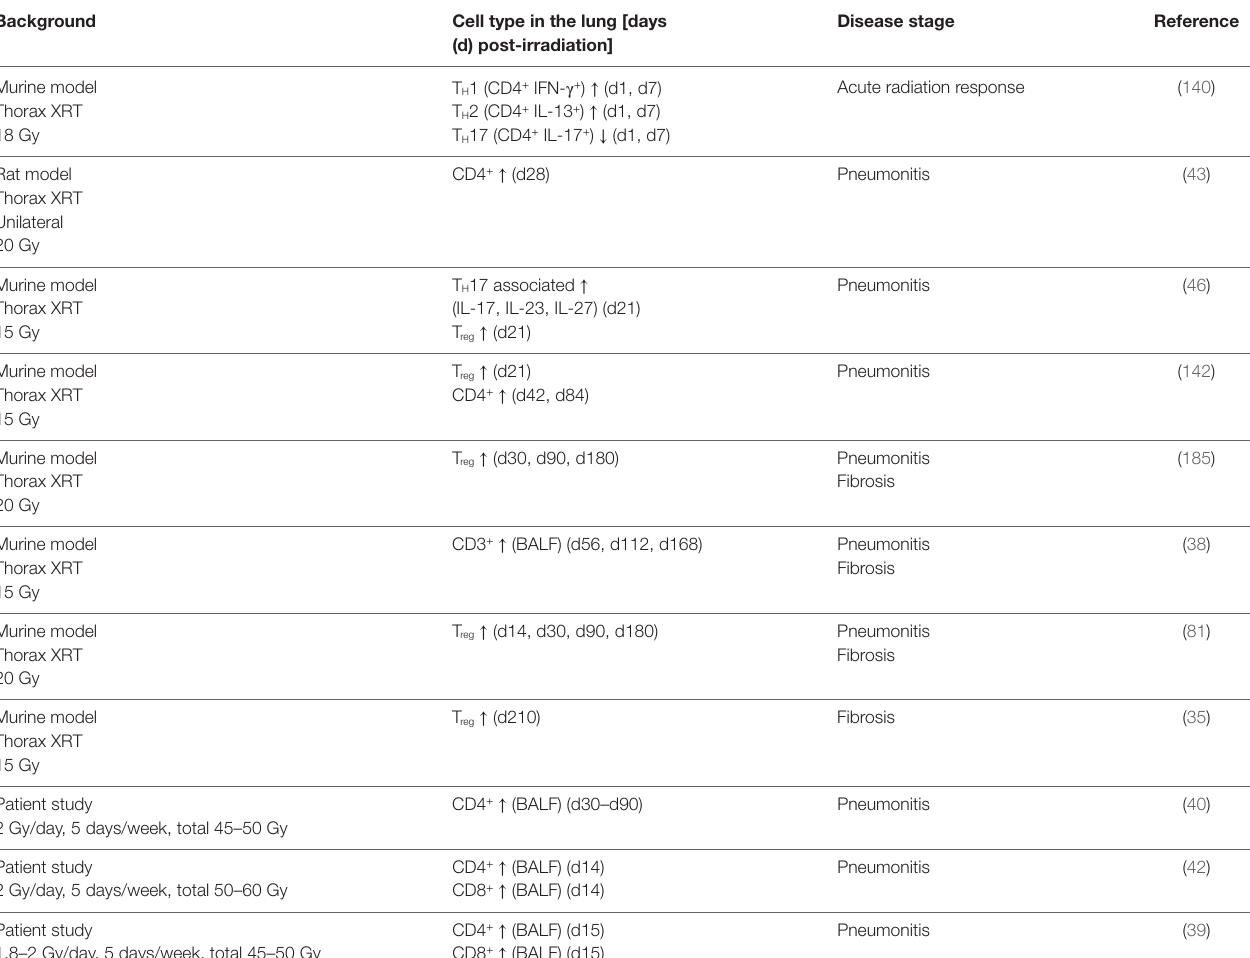
TABLe 1 | Lymphocytes in the irradiated lung.